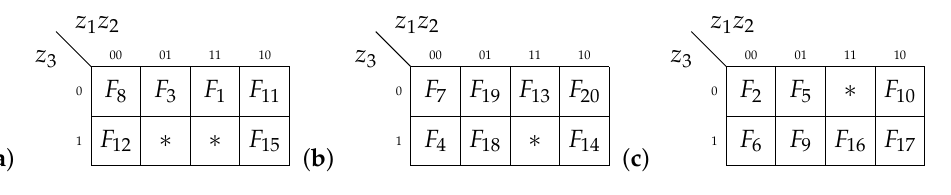
Figure 8. Codes of terms of Mealy FSM U 5 ( S 1 ) . System (46)—( a ), (47)—( b ), (48)—( c